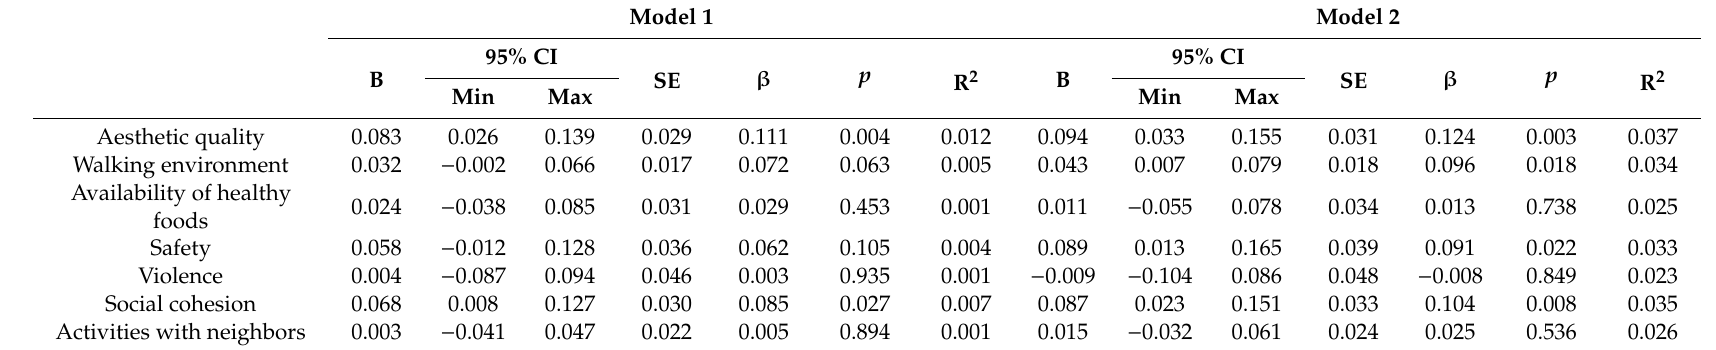
Table 5. Association between neighborhood characteristics and child prosocial